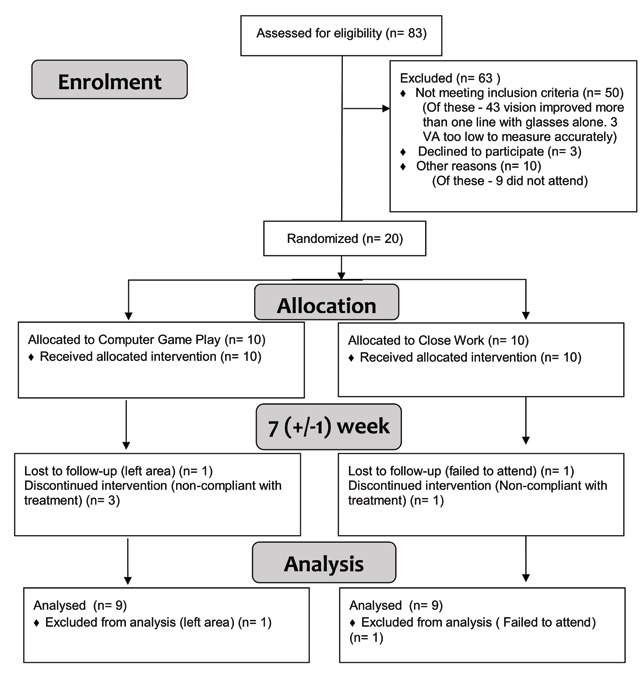
Consort diagram.